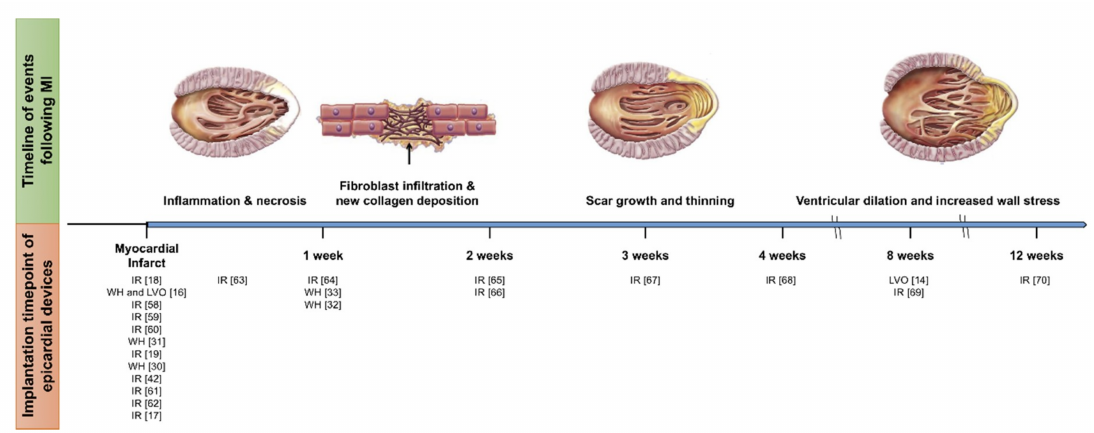
Figure 3. Side-by-side visualization of gross post-myocardial infarction (MI) left ventricular (LV) remodeling and intervention timing of epicardial devices/patches implantation. Illustration modified and reprinted from [71], with permission from Elsevier. IR: Infarct reinforcement; LVO: LV only restraint; WH: Whole heart